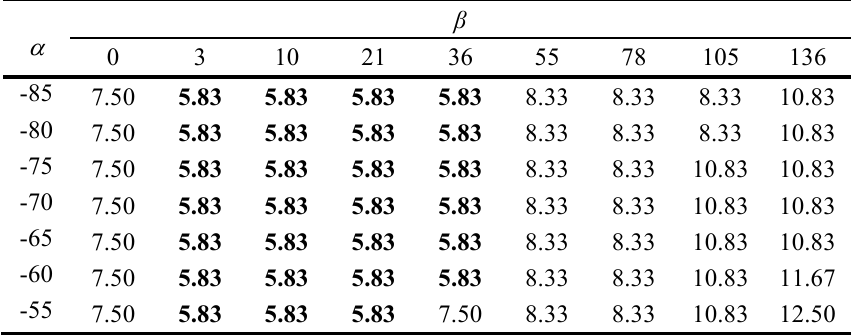
Table 1(a). Variation in percentage error rate for some values of α and β for NTIPS = 3 on Yale face database